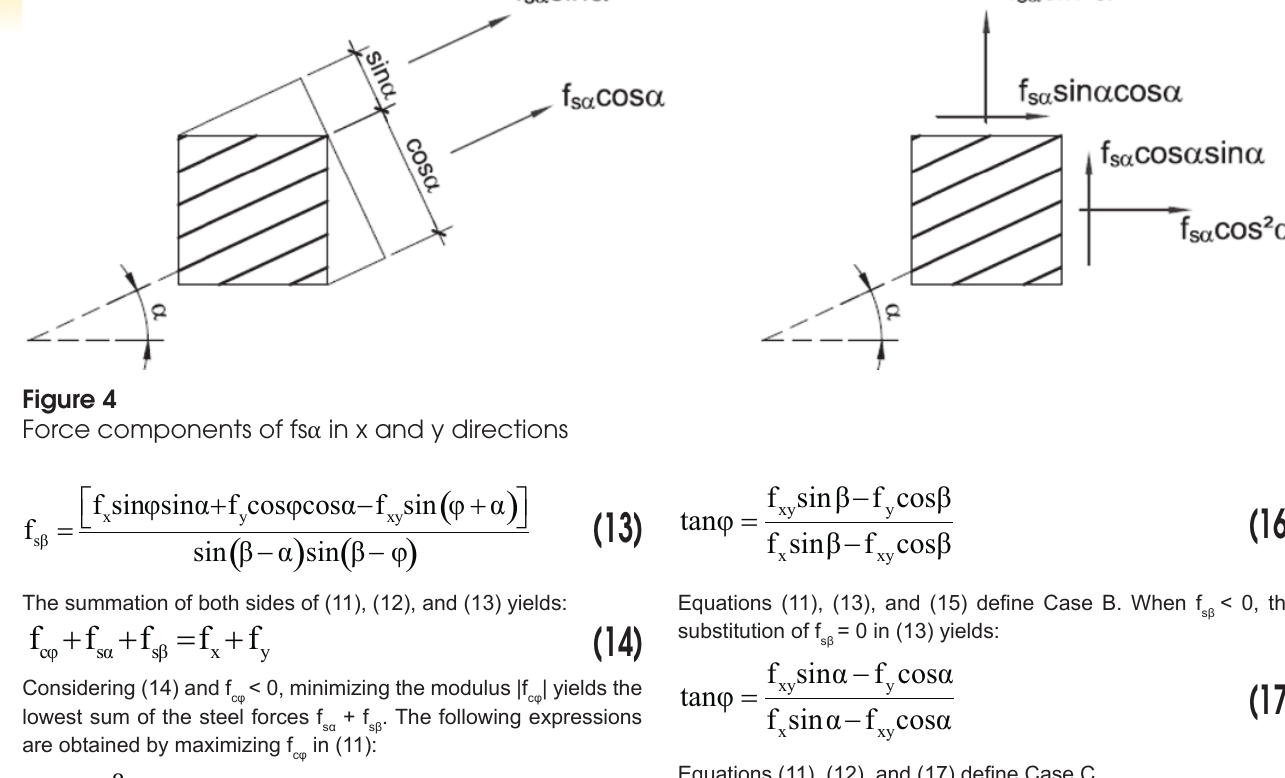
in x and y directions α